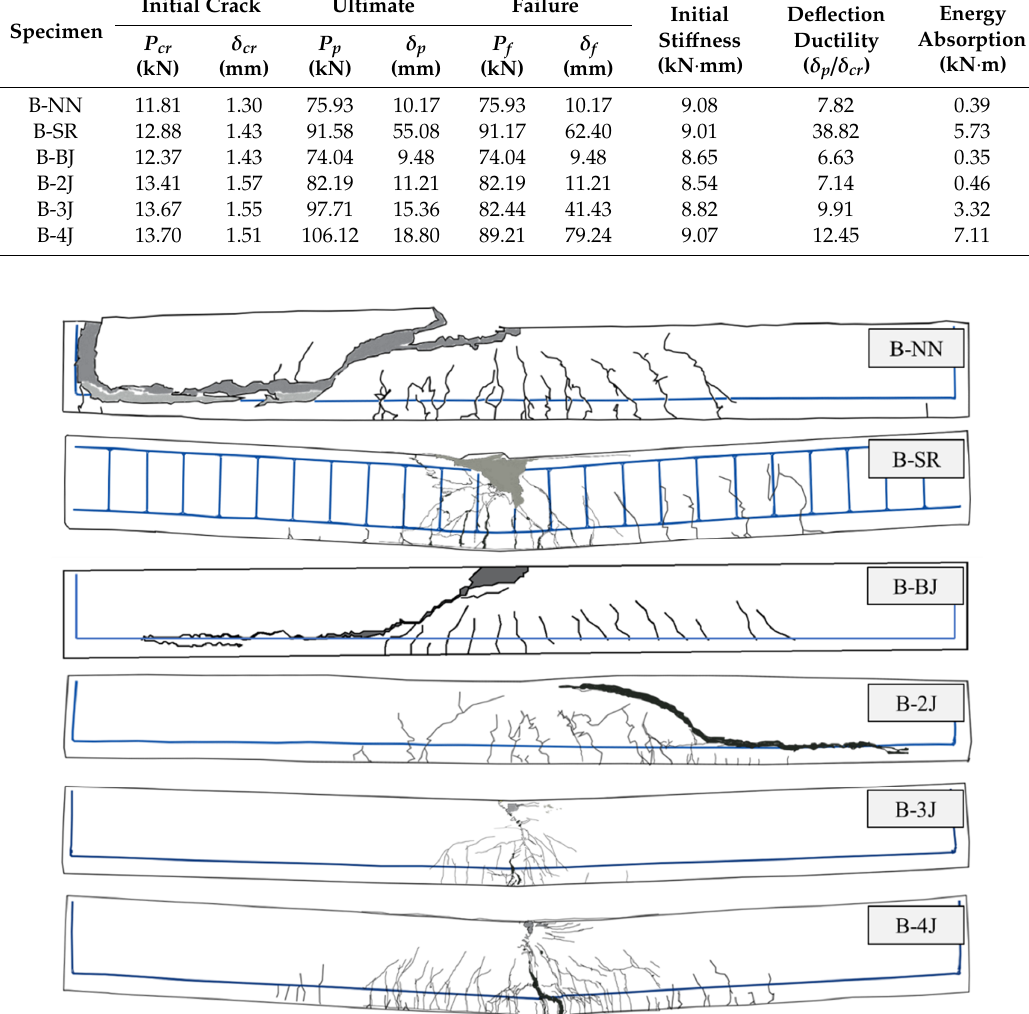
Table 8. Test results of beams.